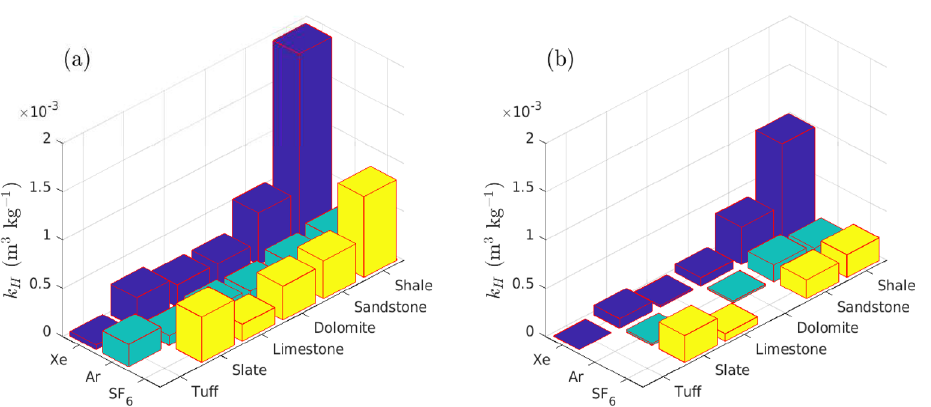
Figure 2. Comparison between Henry’s type and Langmuir isotherms of xenon sorption in shale at 0 ◦ C. ( a ) Langmuir isotherm fits well with experimental data in the full concentration range ( 0 ≤ c ≤ 55 [mol m − ( b ) Henry’s type isotherm approximates experimental data in the low concentration range ( 0 ≤ c ≤ 7 [mol m − ]). The solid curve (blue) represents the Langmuir fit while dashed (magenta) and dotted (black) lines are the Henry’s type fit and the linearized Langmuir fit when b ′ c ≪ 1.